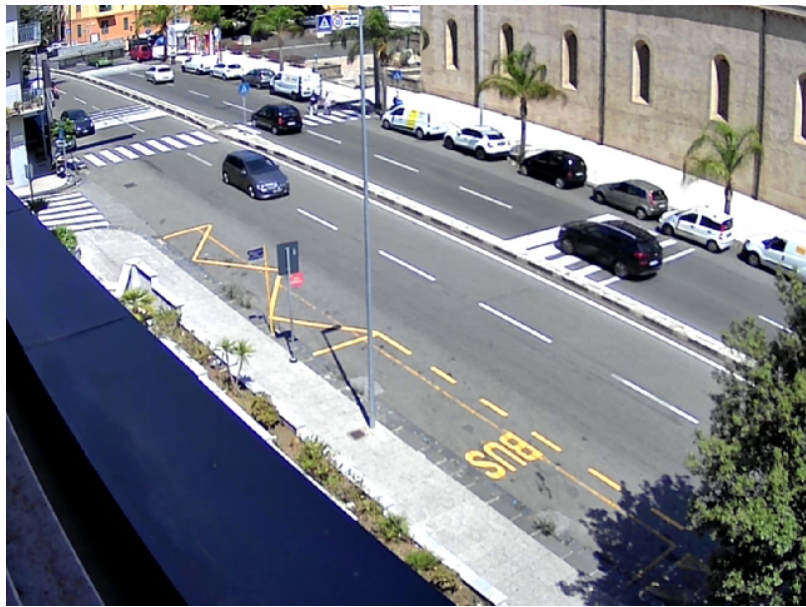
Figure 2. Sample frame captured at 640 × 480